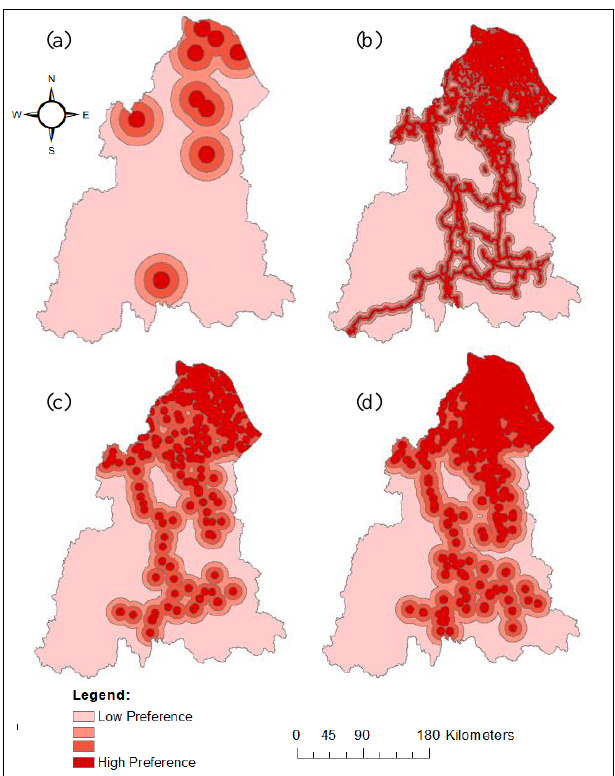
Figure 4. Suitability parameters: (a) proximity to major towns (m); (b) proximity to major roads (m); (c) proximity to